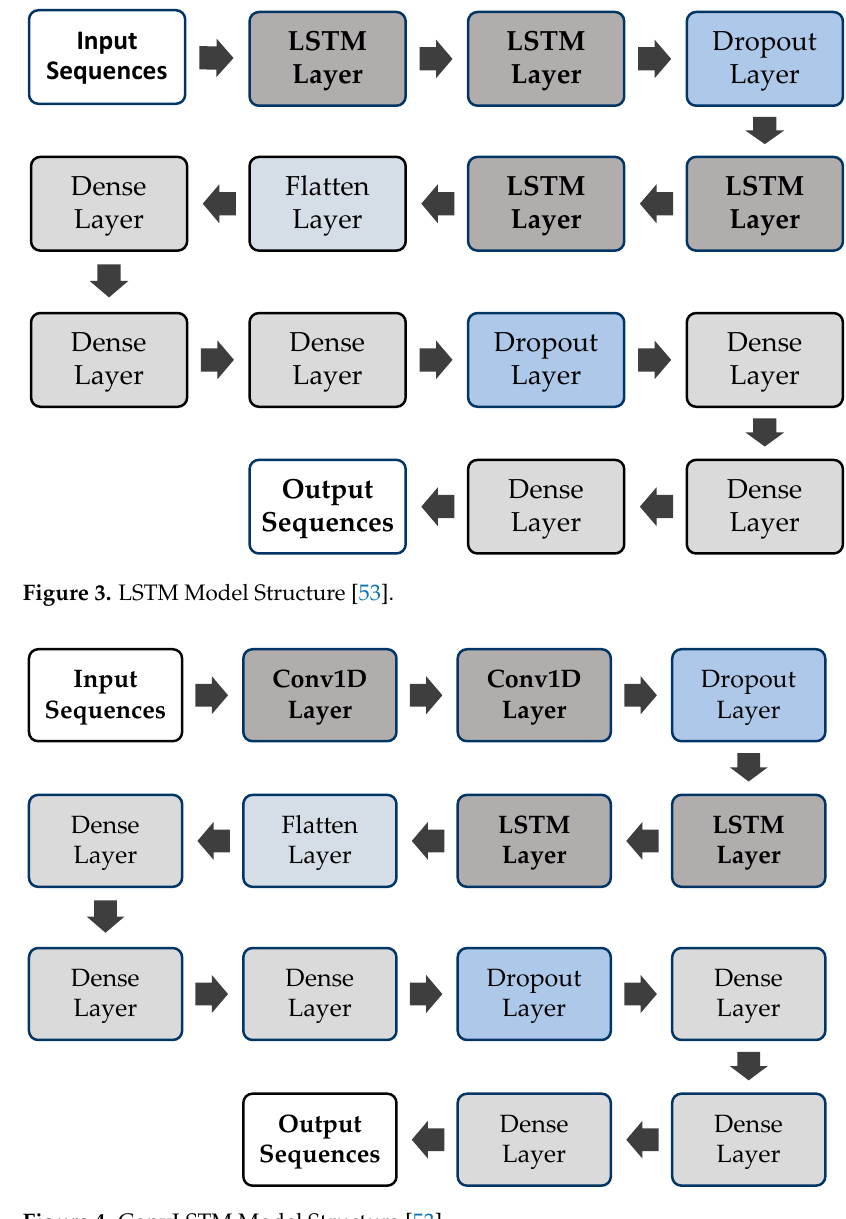
Figure 3. LSTM Model Structure [53].